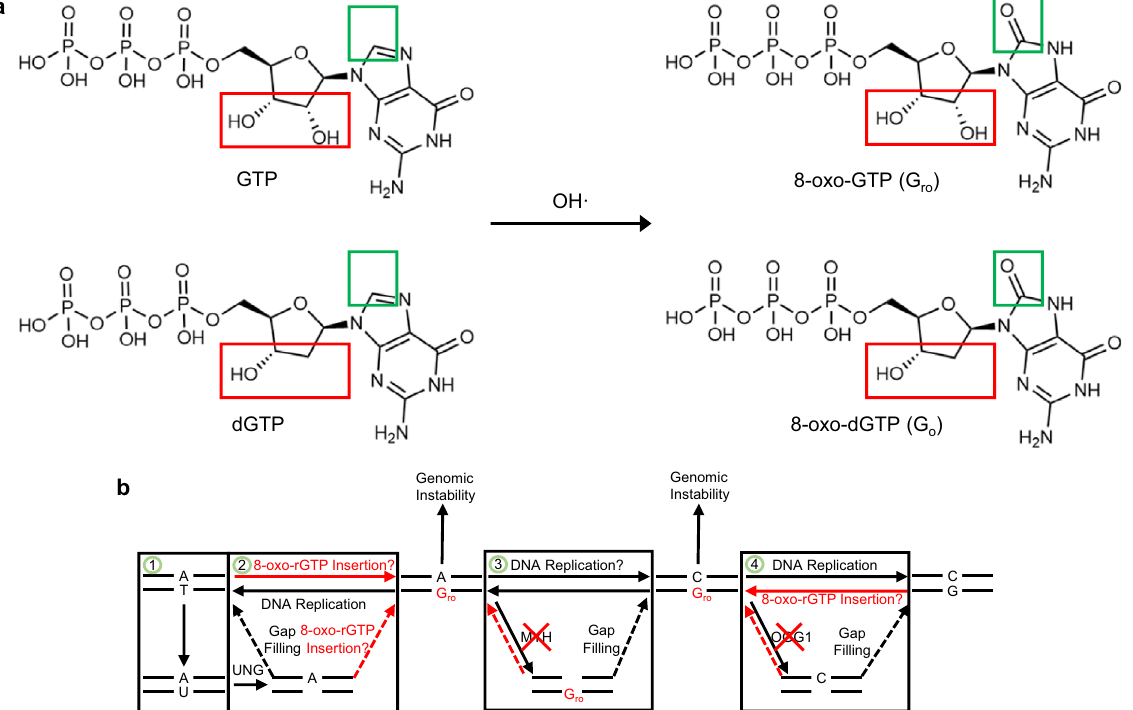
Fig. 1 Repair pathways targeting deoxy-8-oxo-G inef fi ciently process the structurally equivalent ribonucleotide, 8-oxo-rG. a Hydroxyl radicals (OH • ) interact with and damage cellular free dGTP (2´-deoxyguanosine-5´-triphosphate) and rGTP (guanosine-5´-triphosphate) pools. Oxidation by hydroxyl radicals at C8 (green box) of dGTP and rGTP (red box) generates 8-oxo-dGTP (8-oxo-2´-deoxyguanosine-5´-triphosphate, 8dOG or G o ) and 8-oxo-rGTP (8-oxo-guanosine-5´-triphosphate, 8rOG or G ro ), respectively. b Scheme depicting known pathways associated with replication and repair of